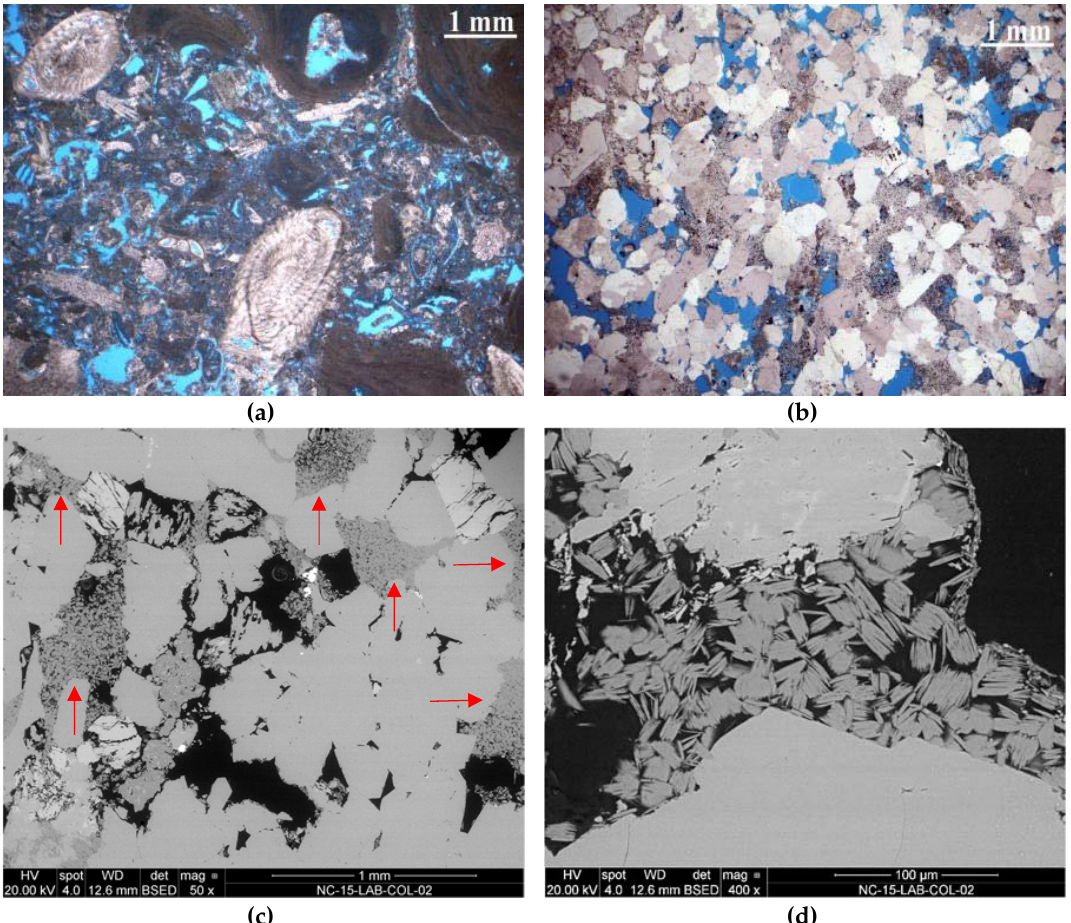
Figure 1. Microphotos of thin sections recorded with a polarised-light microscope (PLM): ( a ) St. Margarethen Limestone with different microfossils such as foraminifers, coralline red algae and debris of echinites; ( b ) Schlaitdorf Sandstone : a coarse-grained quartz arenite with kaolinite and sparitic dolomite; Microphotos of cross sections recorded with a scanning electron microscope (SEM): ( c ) occurrence of kaolinite (red arrows) up to 15% in Schlaitdorf Sandstone indicating its even distribution throughout the fabric; ( d ) detail of kaolinite in the intergranular pore space between quartz and feldspar.